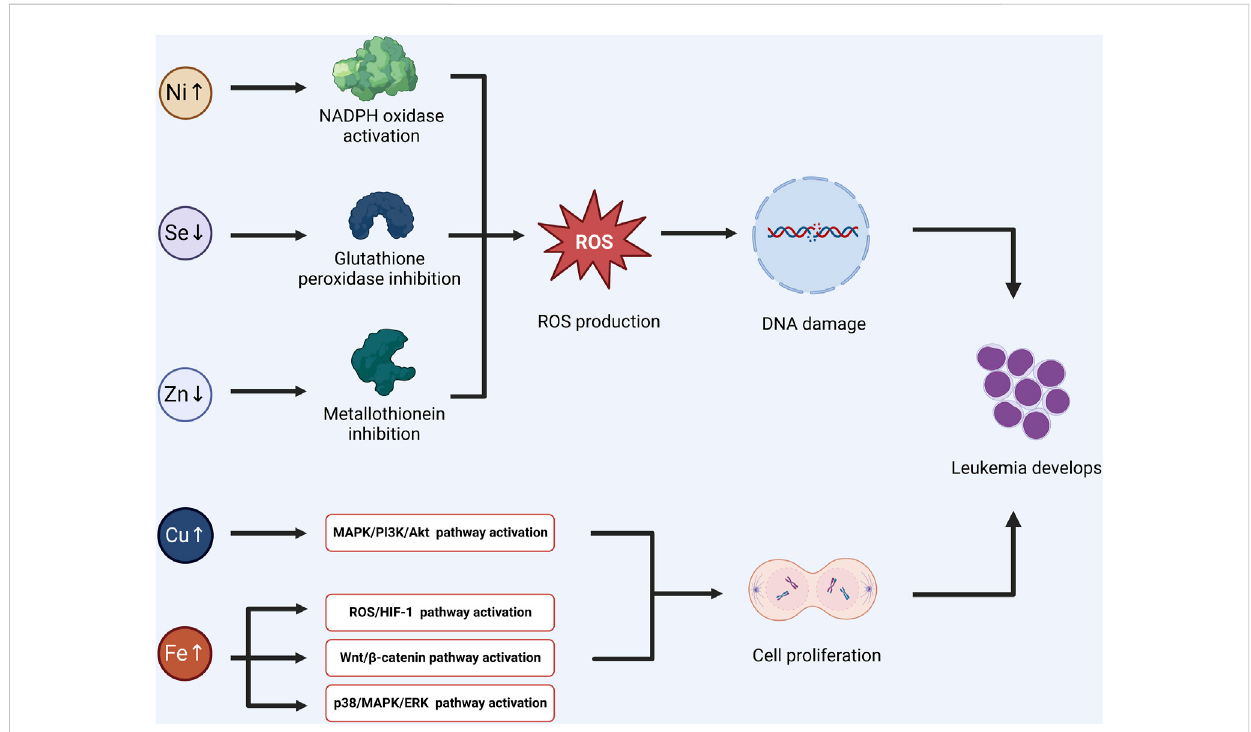
FIGURE 1 Some trace elements can affect the activity of related enzymes, induce redox imbalance, and lead to DNA damage and mutation. The other trace elements may promote the activation of signal pathways, and induce the proliferation and division of tumor stem cells. Combining the above two mechanisms,thepossiblepathogenesisofacute lymphoblastic leukemia induced bytraceelementswassummarized.(Ni:Nickel,Se:Selenium,Zn: Zinc, Cu: Cupper, Fe: